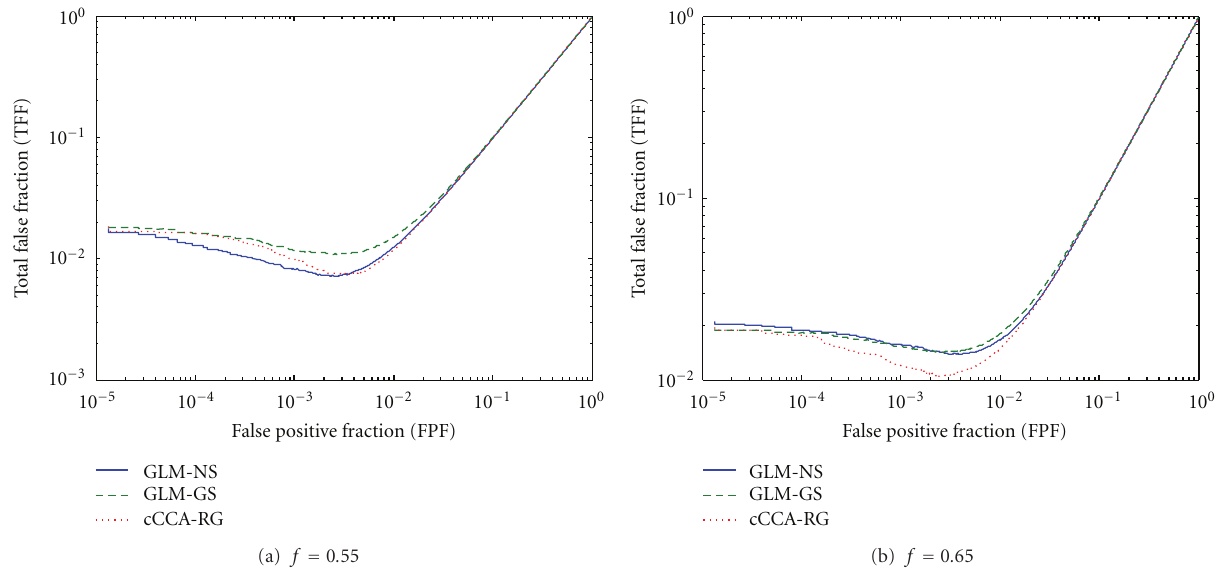
Figure 6: The total false fraction (TFF) (including false positives and false negatives) versus the false positive fraction (FPF) for the contrast E-C of the memory paradigm for pseudoreal data: (a) the low noise case ( f = 0 . 55) and (b) the high noise case ( f = 0 . 65). Note that all TFF curves have minima in the interval [0 . 001,0 . 01]. The cCCA-RG method is optimal in both the low and high noise cases.